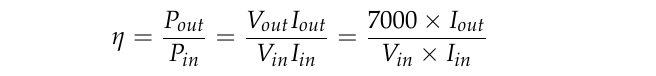
Figure 13. Ripple of the output high voltage.